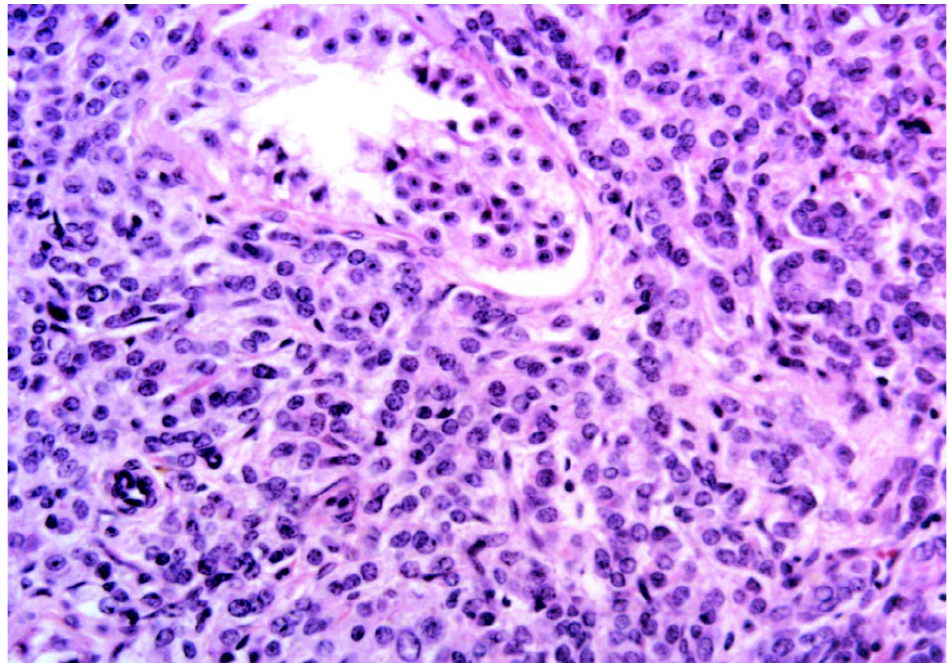
Figure 1 – Neoplasm infiltrating the testis. The seminiferous tubule is involved with non-differentiated neoplastic cells (HE,